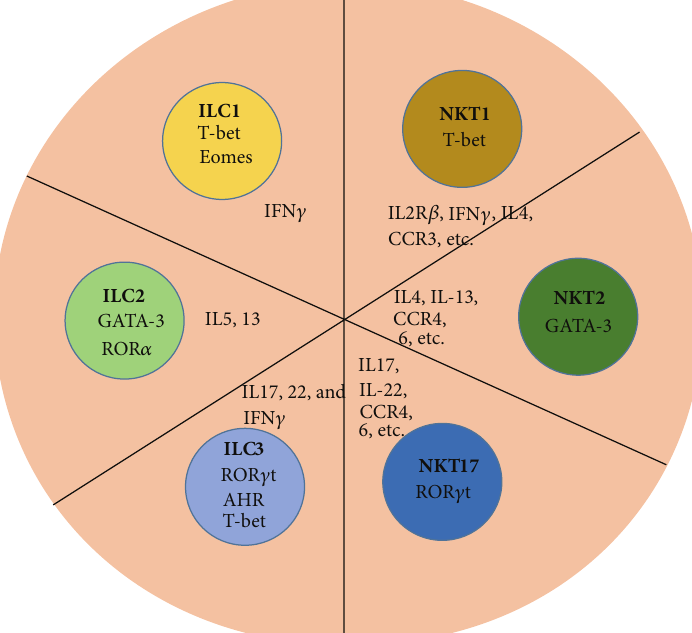
Figure 1: Conserved lineage diversification in ILCs and NKT cells. NKT cells as well as ILCs can be divided into three separate sublineages that resemble Th1, Th2, and Th17 subsets in conventional CD4-positive T cells. Group 1 ILCs are characterized by the expression of either T-bet (ILC1) or T-bet and Eomes (NK cells). Group 2 ILCs are defined by the expression of ROR 𝛼 and GATA3 as well as their ability to release Th2 cytokines. Three sublineages are summarized under the umbrella of group 3 ILCs. While NK cell receptor-negative ILC3s only depend on ROR 𝛾 t, lymphoid tissue-inducer (LTi) cells require the aryl hydrocarbon receptor (Ahr) in addition to ROR 𝛾 t. NK cell receptor-expressing ILC3s depend on three transcription factors, AhR, ROR 𝛾 t and